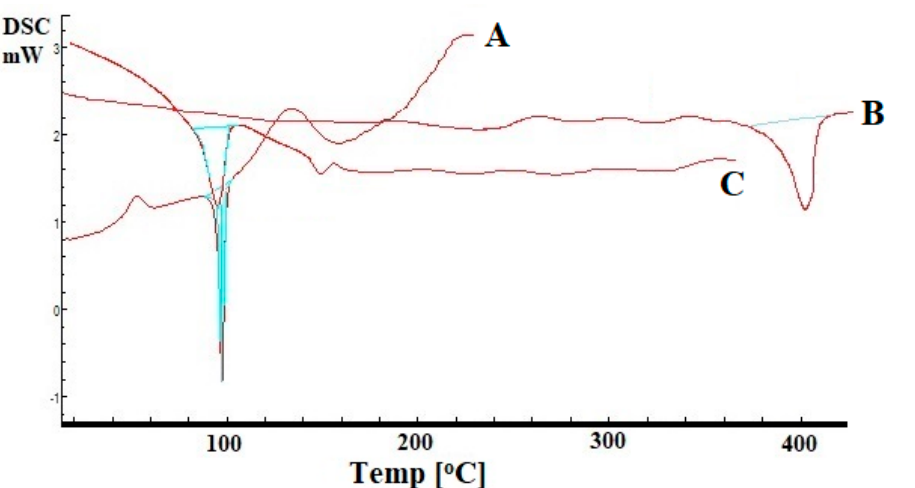
Figure 7. Overlay DSC thermograms of (A) pure Saxagliptin, (B) Eudragit RS100, and (C) optimized SLN formulation.